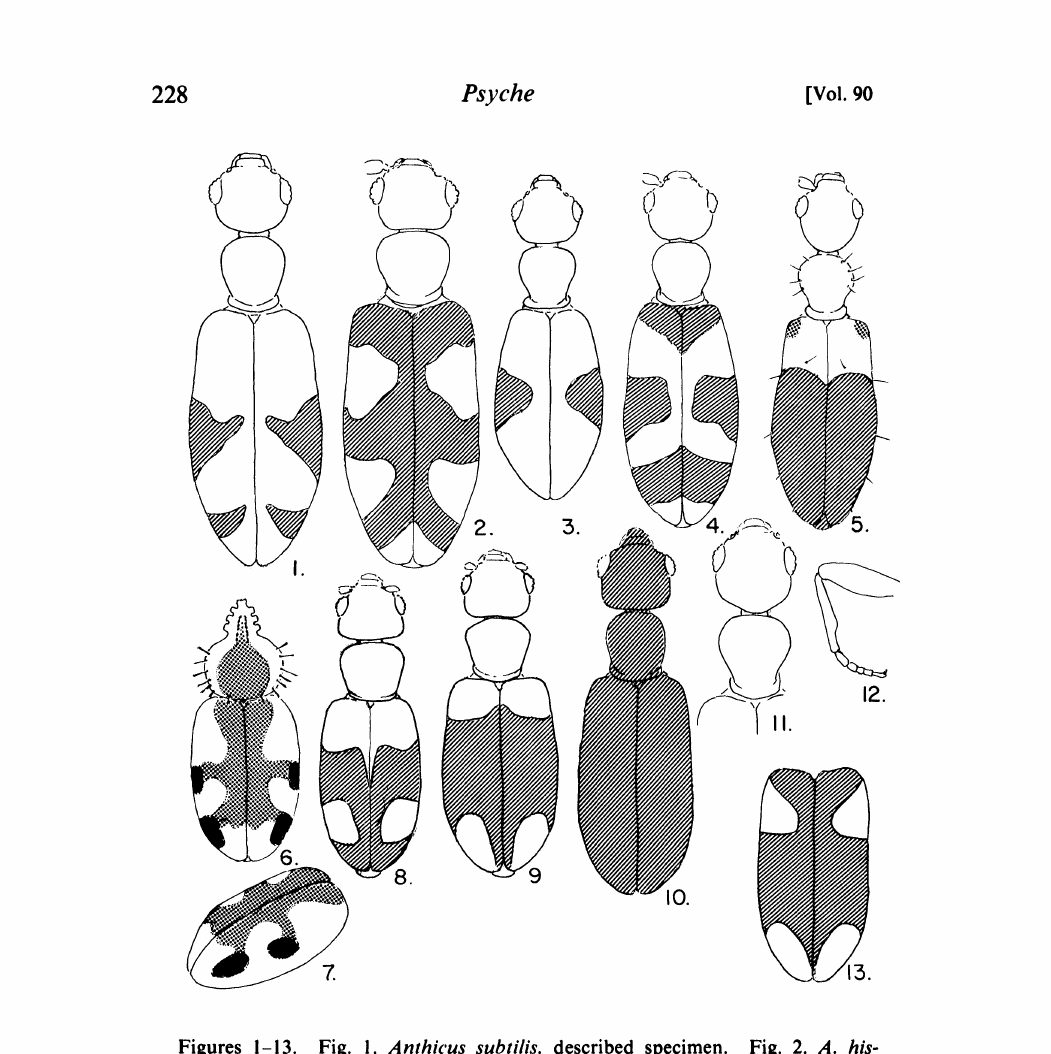
Fig. 5. A. russoL described specimen. Fig. 6. Mecynotarsus hispaniolae, holotype. . Fig. 7. Same specimen, oblique lateral view of elytra. Fig. 8. Anthicus margaritae, holotype. Fig. 9. A. antilleorum, holotype. Fig. 10. A. blackwelderL holotype. Fig. 11. Thicanus texanus, Barahona, Rep. Dom., forebody. Fig. 12. Anthicus macgillavryL front leg of described Fig. 13. A. blackwelderL elytral markings of Cuban population, from coast below Pico